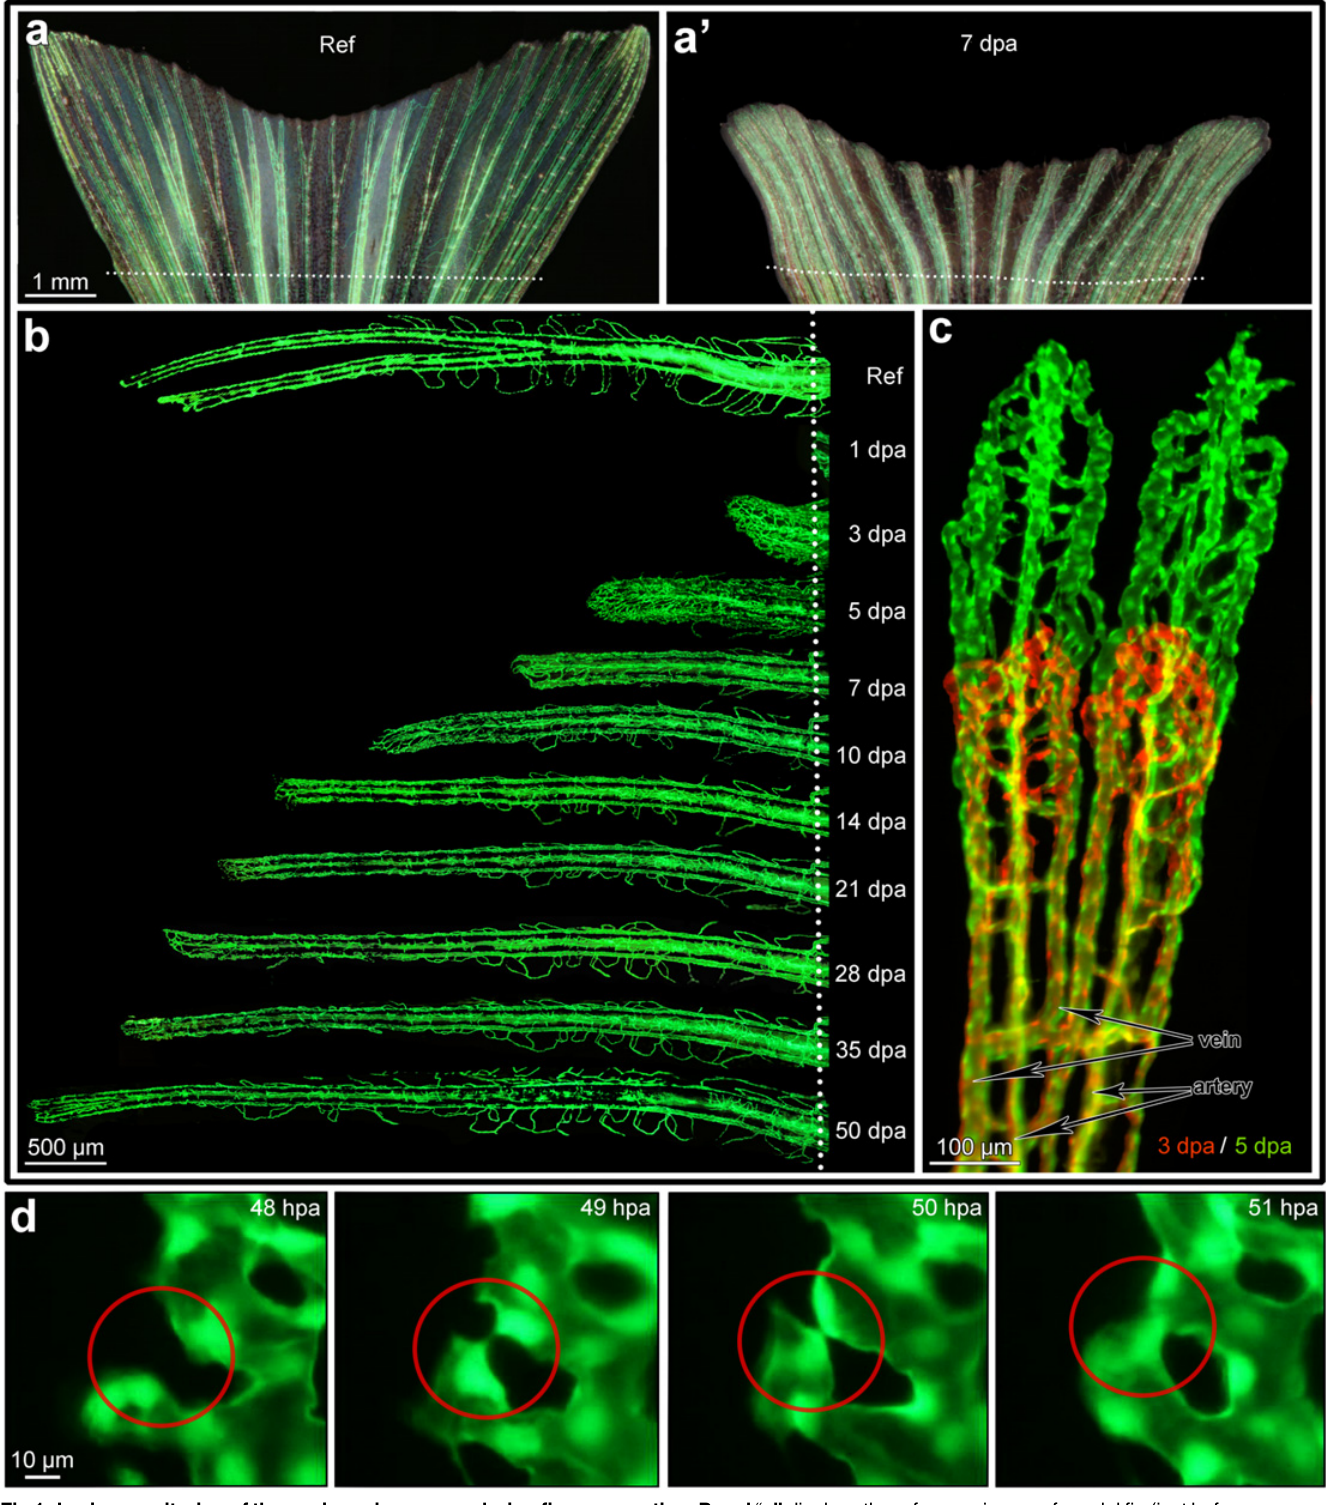
Fig 1. In vivo monitoring of the angiogenic process during fin regeneration. Panel “ a ” displays the reference image of caudal fin (just before amputation) taken with both normal bright and fluorescent reflected light. The vessels appear green (eGFP in Tie-2 positive endothelial cells). Panel ” a ‘” displays a representative image of the regenerated caudal fin at 7 dpa (days post amputation). The dotted line indicates the amputation level. Panel “ b ”